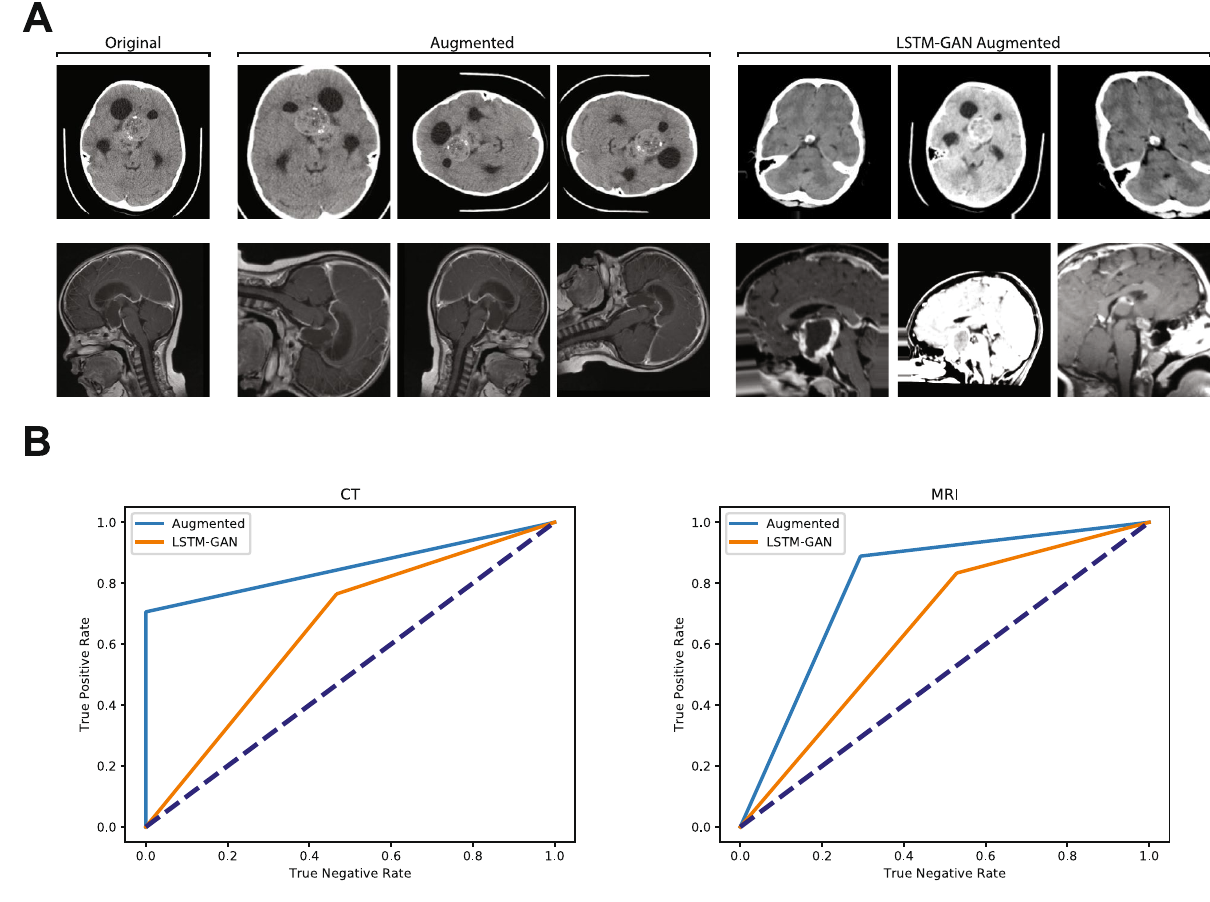
Figure 4. Test performance of models trained on stochastic image augmentation and GAN-LSTM augmented images. ( A ) Exemplar images of original training CT (top) and MRI (bottom), with randomly augmented variants, and TANDA-augmented variants. ( B ) ROC curves for CT- and MRI-trained networks comparing top results of supervised augmented images and TANDA-generated images. Dashed lines represent ROC curve of random chance